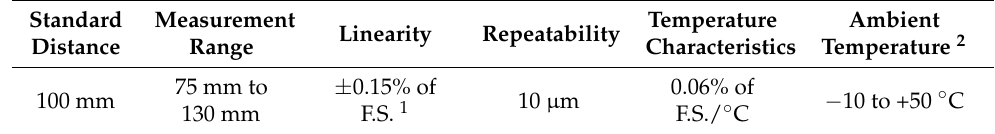
Table 1. The performance parameters of the range sensor.